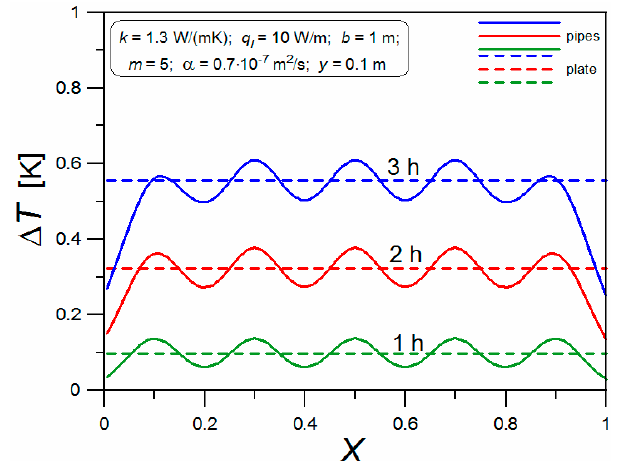
Figure 7. The comparison of the ground temperature increment ∆ T for pipe exchanger and flat plate exchanger.